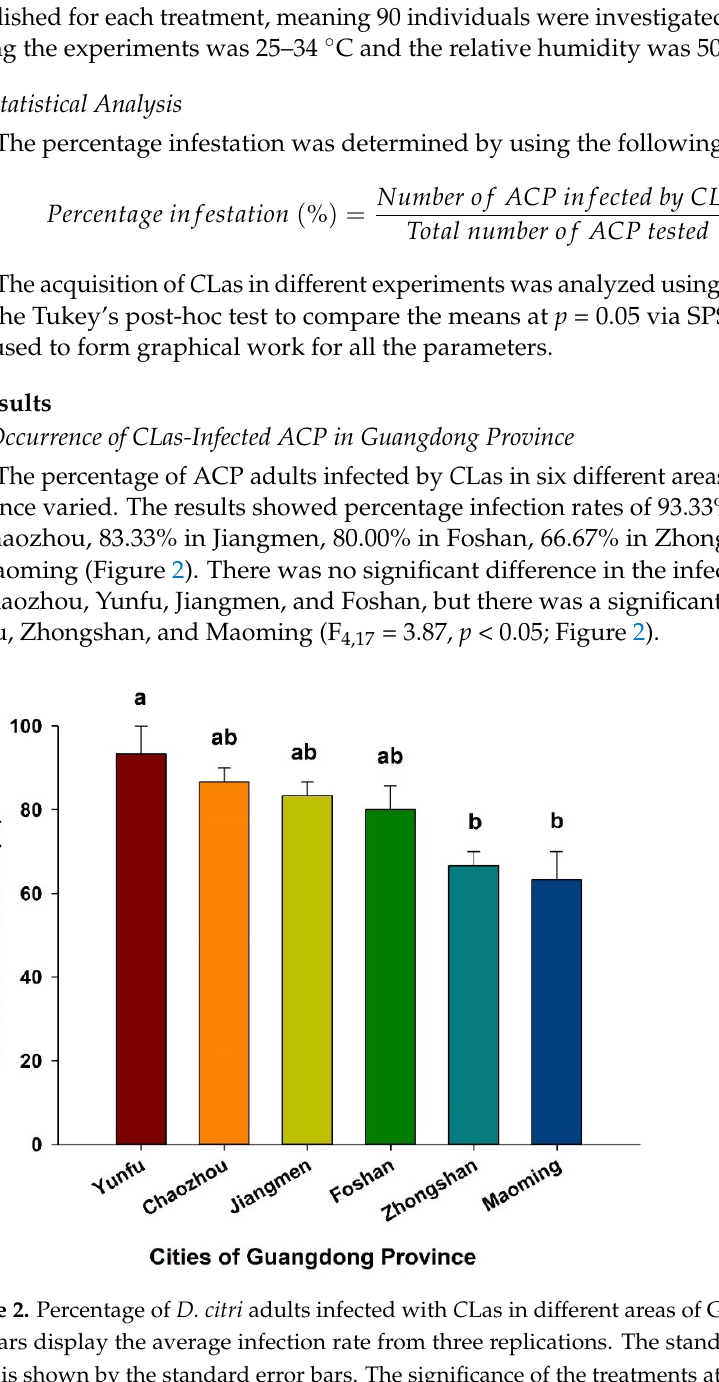
Figure 3. Percentage of C Las-positive D. citri adults feeding on C Las-infected citrus plants for dif- ferent time durations. The bars display the average from three replications. The standard deviation of the mean is shown by the standard error bars. The significance of the treatments at p < 0.05 is shown in lowercase lettering. Similar letters represent no significant difference among the treat- ments.